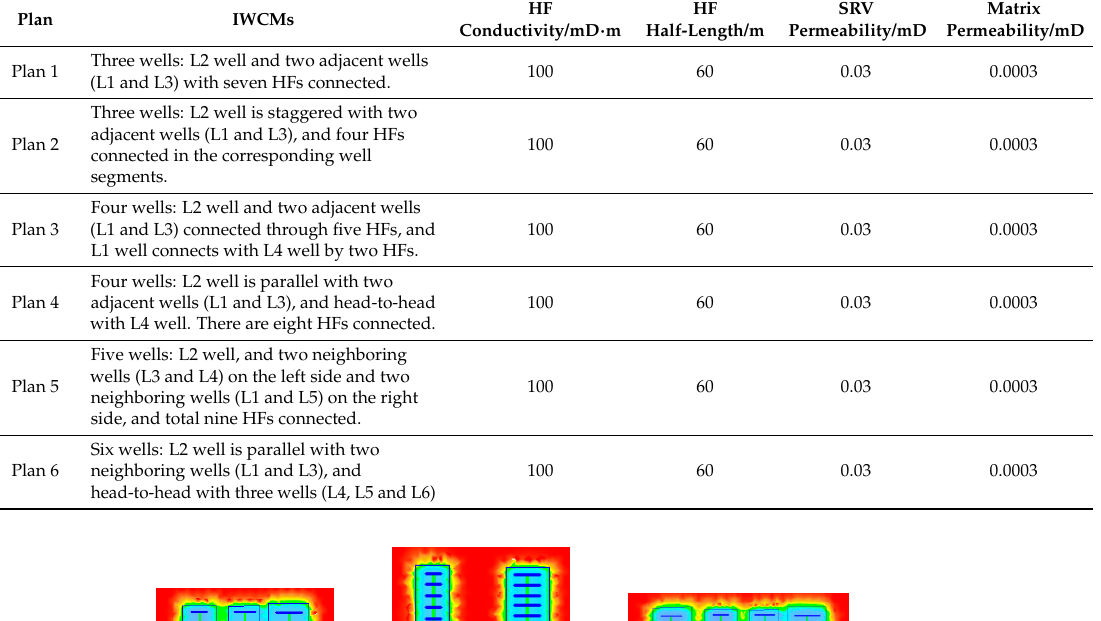
Table 3. IWMDs and basic physical properties of six plans.